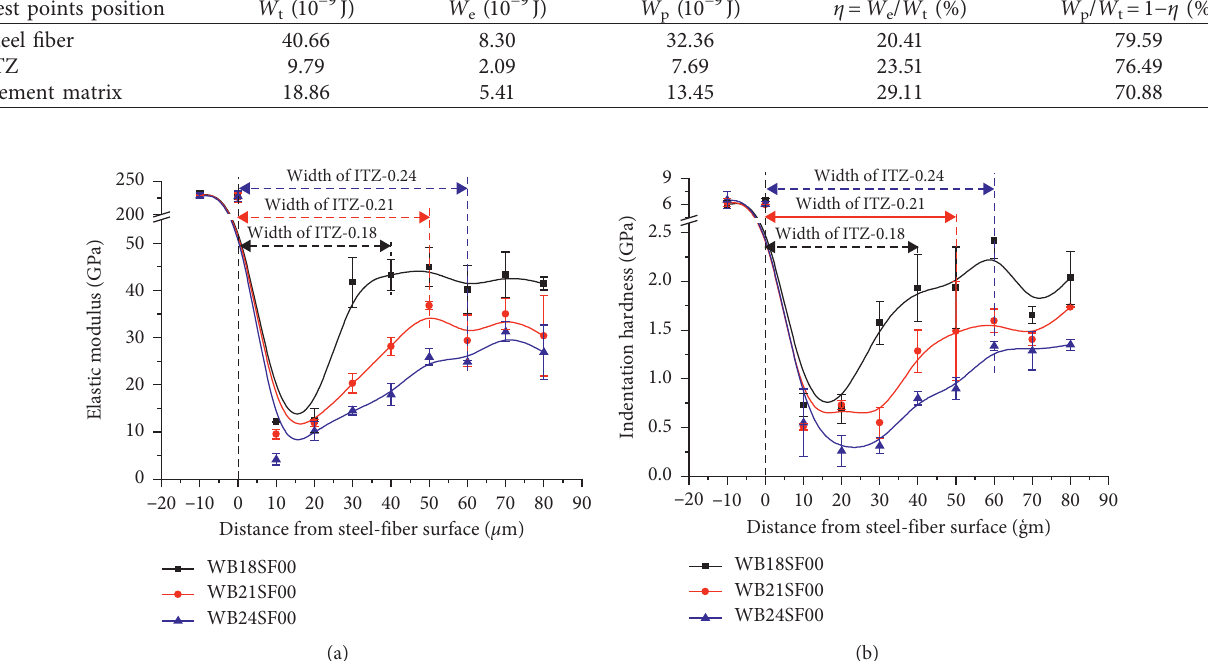
Figure 5: Test indices versus distance from the steel-fiber surface under different water-cement ratios. (a) Elastic modulus. (b) Indentation hardness. Table 4: Test indices of ITZ and cement matrix under different water-binder ratios.